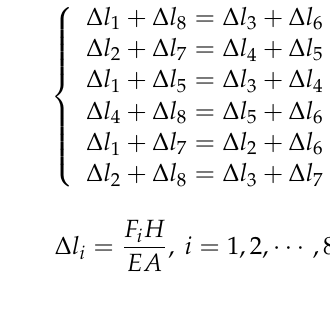
(cid:3404) 0, 𝐹 (cid:3053) (cid:3404) 0, 𝐿(cid:4666)𝐹 (cid:3051)